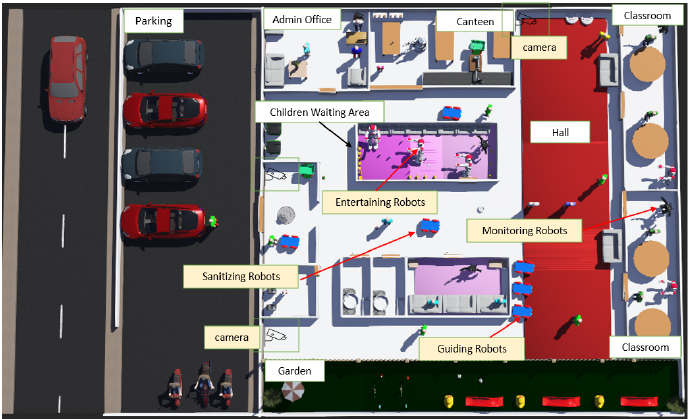
Figure 9. Early Learning Centre Domain showing an IoT collective consisting of multiple robots, smart cameras with teachers and